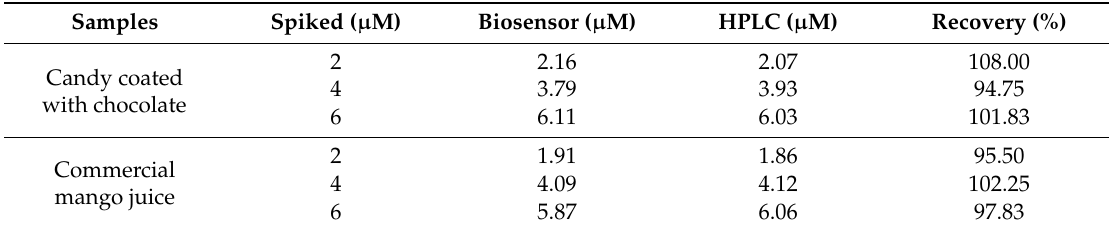
Table 2. Determination of tartrazine in candy coated chocolate and commercial mango juice samples by microspheres-laccase/AuNPs/SPE modified electrodes ( n = 3).